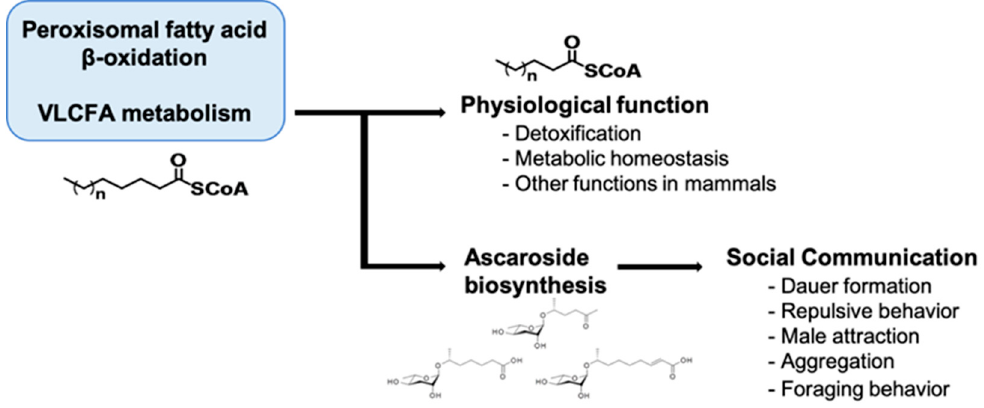
Figure 5. A schematic diagram for the dual role of peroxisomal fatty acid (FA) β -oxidation. By shortening VLCFAs, peroxisomal fatty acid β -oxidation can exert physiological functions such as detoxification and maintenance of metabolic homeostasis. In Caenorhabditis elegans , shortened FAs are used to synthesize ascr pheromones, which are important for social communication.